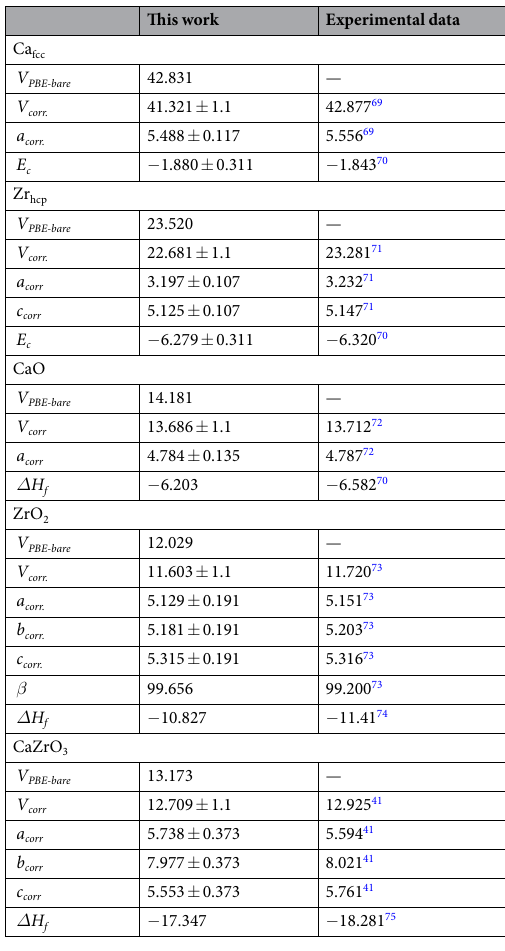
Table 1. The calculated V PBE-bare : bare PBE equilibrium volume per atom (Å 3 /atom); V corr . : zero-point corrected equilibrium volume per atom (Å 3 /atom); a corr . , b corr . and c corr . : lattice parameters corresponding to V corr . (Å 3 / atom); E c : cohesive energies (eV/atom); and Δ H f : enthalpy of formation (eV/formula unit); along with experimental data. The residual error bar for zero point corrected equilibrium volume per atom and cohesive energies are explained in the